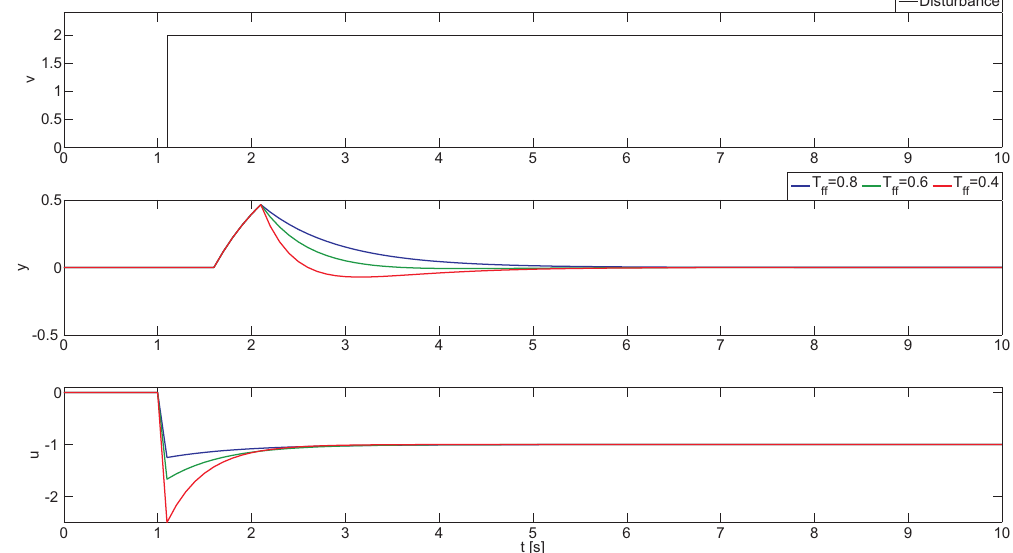
Figure 2. Time-domain response of the open-loop disturbance compensation for a step change in v at t = 1 and the following process: P u ( s ) = 1